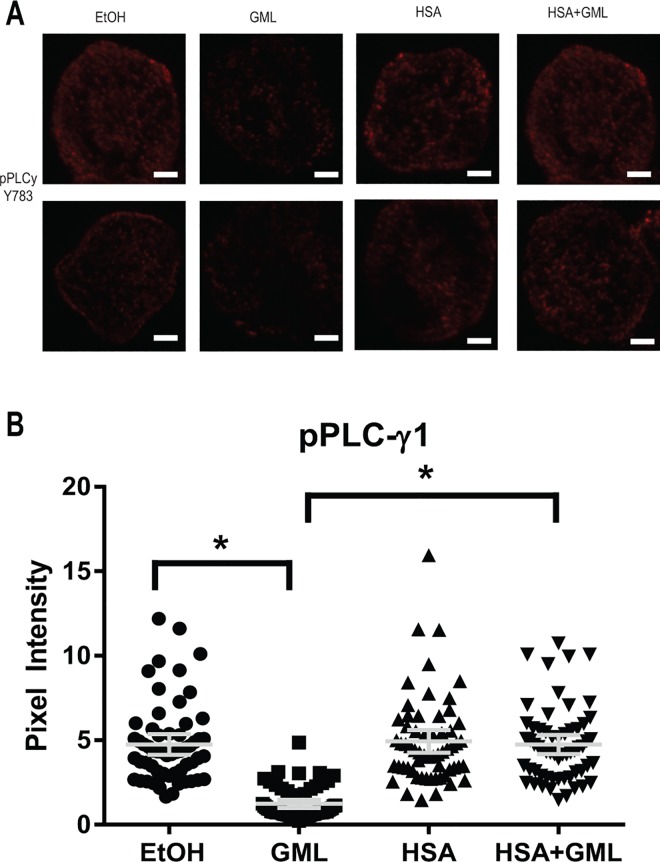
HSA allows for PLC-γ1 microcluster formation in GML treated cells.(A). APBTs treated with 0.1% ethanol or 10 μg/ml GML in serum free media as well as 0.1% ethanol or 10μg/ml GML in 1% HSA were stimulated by plate bound anti-CD3 (2 μg/ml) in glass covered chamber slides. They were then fixed, permeabilized, stained with antibody specific for phosphorylated PLC-γ1 Y783, and imaged using TIRF microscopy. White bar scale indicates 4 μm in length. (B). Pixel intensities of median axis of each cell in images obtained in (A) were quantified and averaged using ImageJ. Scatter plot distributions with 95% confidence intervals of 60 cells from 3 independent experiments are shown. * denotes p<0.05 in Student t’s test comparing the identified samples.